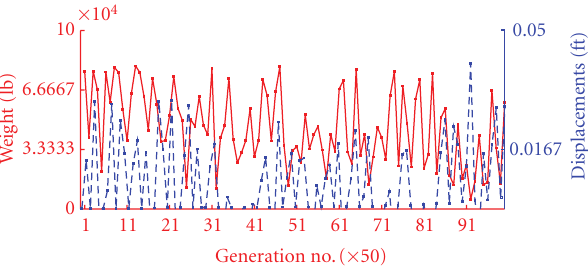
Figure 5: Convergence history obtained by AbYSS (Case